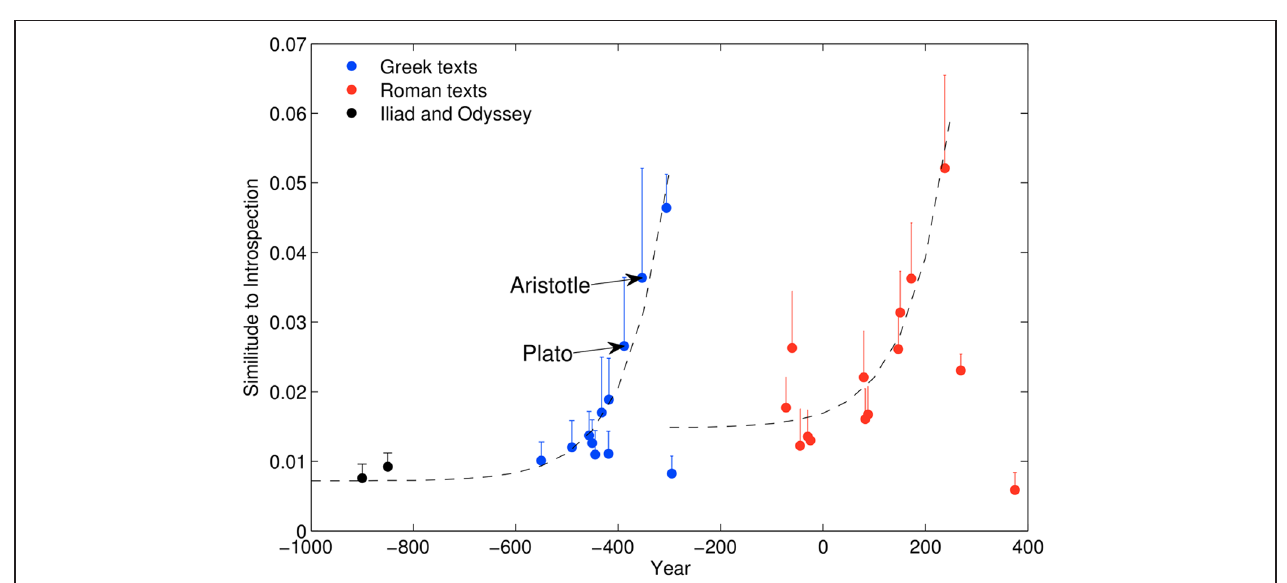
FIGURE 2 | Introspection in the cultural record of the Greco-Roman tradition. Dotted lines represent exponential fits for each of the traditions.